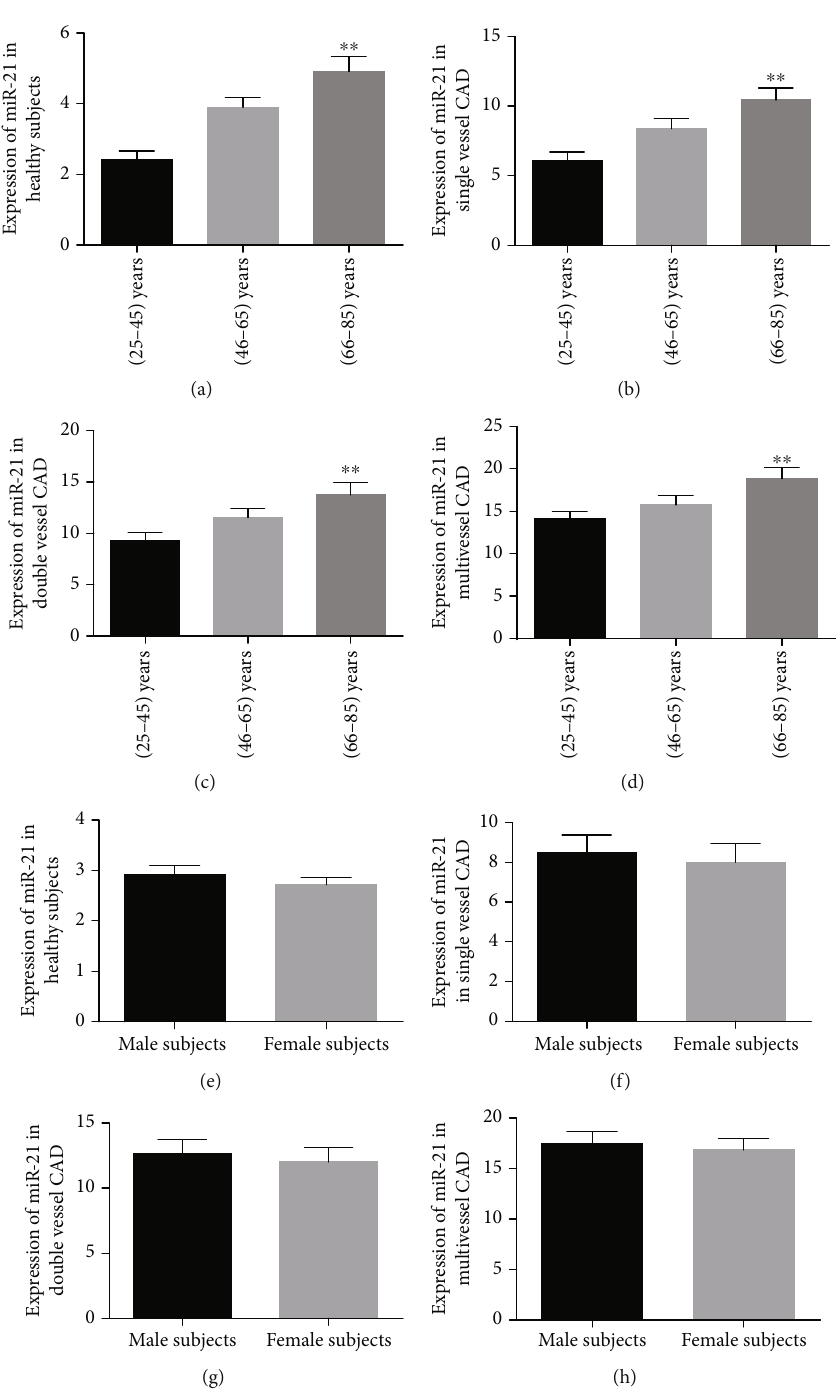
Figure 5: The relative expression of circulatory mir-21 in di ff erent aged subjects and both male and female genders: (a) the expression patterns of plasma mir-21 among healthy groups; (b) plasma mir-21 concentrations in single-vessel CAD subjects; (c) the expression of mir-21 levels in double-vessel CAD patients; (d) multivessel CAD patients ’ mir-21 levels; (e) healthy male and female groups ’ mir-21 expressions; (f) the levels of plasma mir-21 in male versus female single-vessel CAD groups; (g) the concentrations of circulatory mir-21 among male and female double-vessel stenosis CAD subjects; (h) the mir-21 levels between male and female multivessel blocked CAD